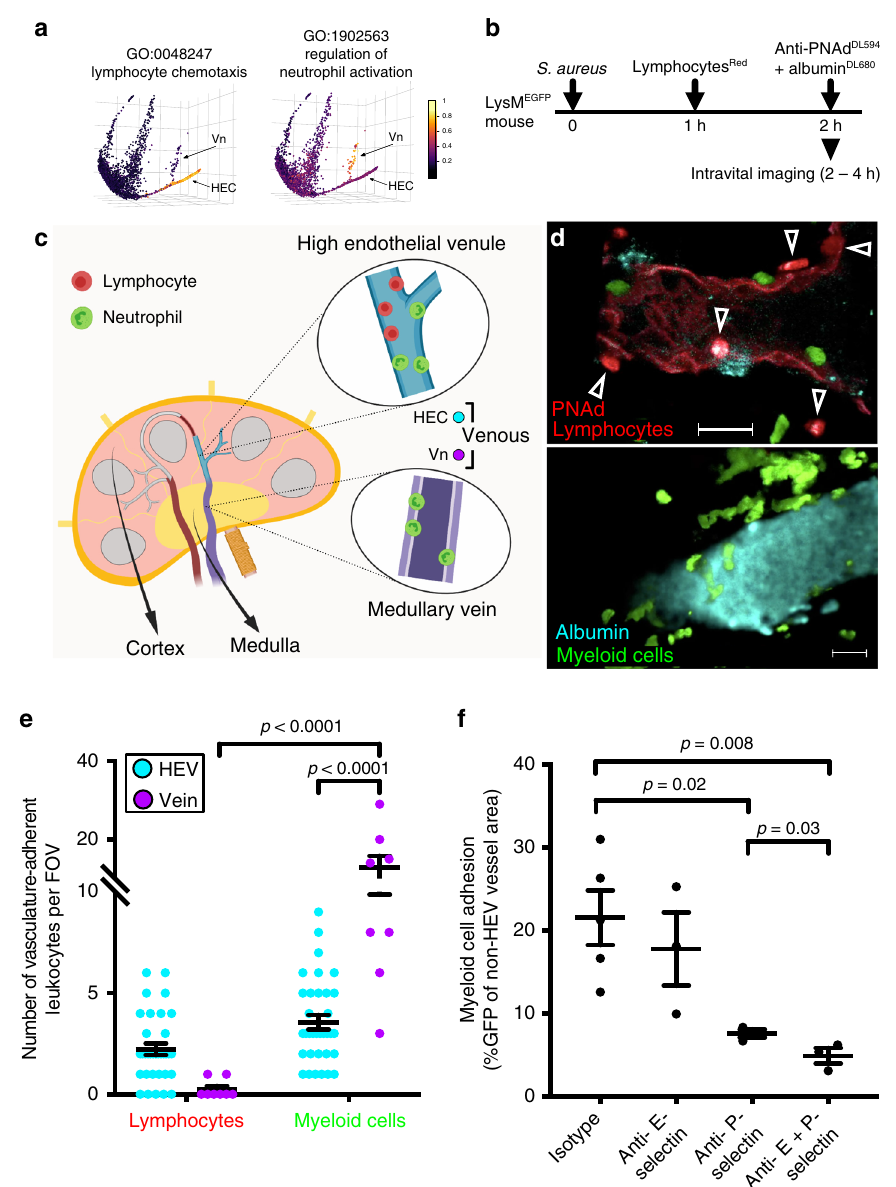
Fig. 3 Medullary veins recruit myeloid cells but not lymphocytes in acute in fl ammation. In situ lymphocyte and myeloid cell recruitment in HEV versus medullary veins of S. aureus infected LysM GFP mice. a Pooled expression values of genes from the indicated GO terms (color scale) plotted along the tSpace projection from Fig. 1e. b Experimental protocol for S. aureus injection and visualization of lymphocyte and myeloid cell traf fi cking in LN. LysM GFP recipients received 2.5 × 10 7 S. aureus in the footpad. One hour later mice were injected i.v. with CMTPX-labeled lymphocytes (red). The draining LN was imaged from 2 – 4 h post infection using two-photon videomicroscopy. c Schematic depicting the location of HEV and medullary veins